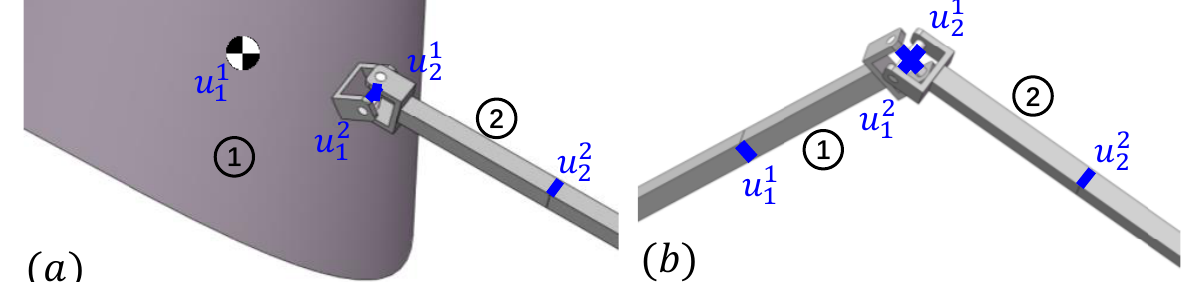
Figure 3. ( a ) Case 2, rigid body – flexible beam. ( b ) Case 3, flexible beam – flexible beam .